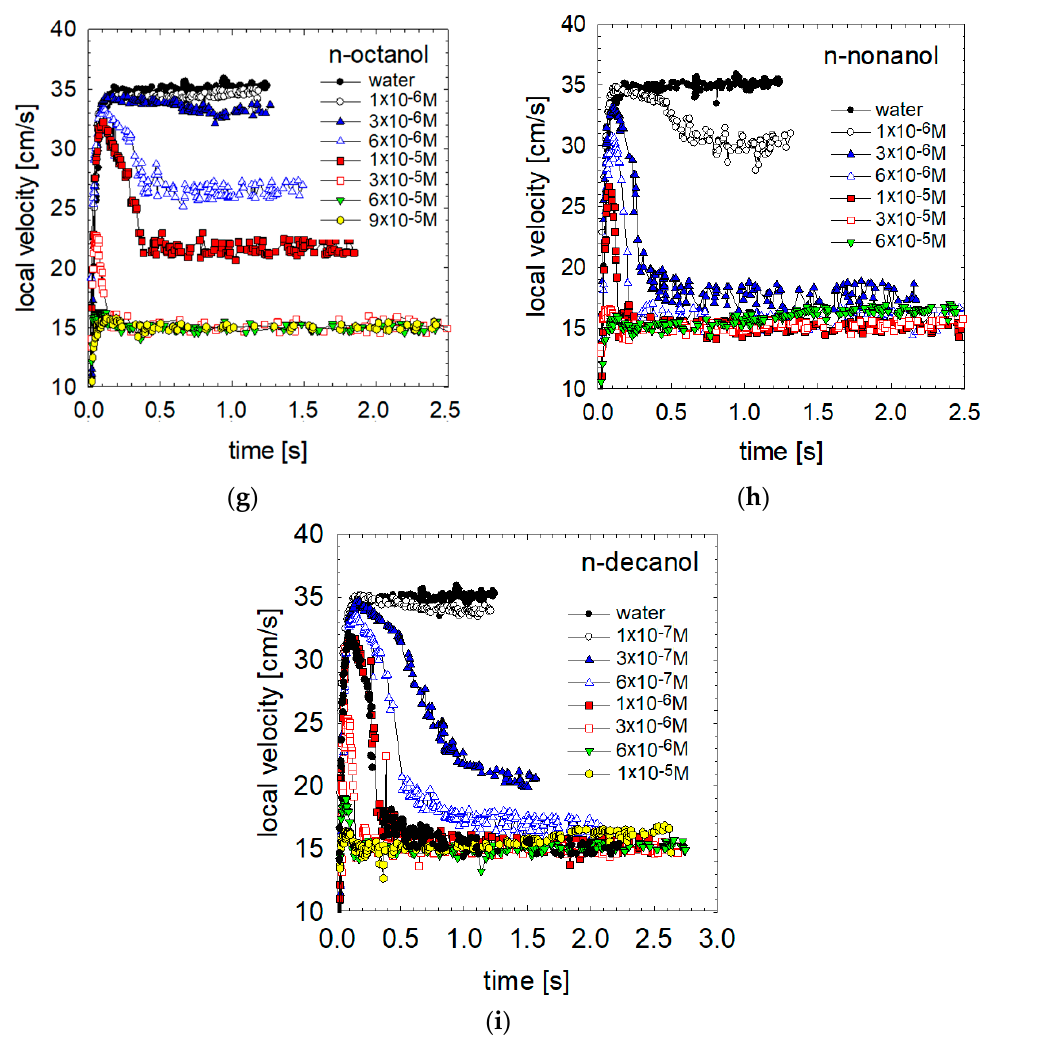
Figure 2. Bubble local velocity as a function of time in solutions: ( a ) ethanol, ( b ) n-propanol, ( c ) n-butanol, ( d ) n-pentanol, ( e ) n-hexanol, ( f ) n-heptanol, ( g ) n-octanol, ( h ) n-nonanol and ( i ) n-decanol. (t = 0—time of the bubble detachment from the capillary).